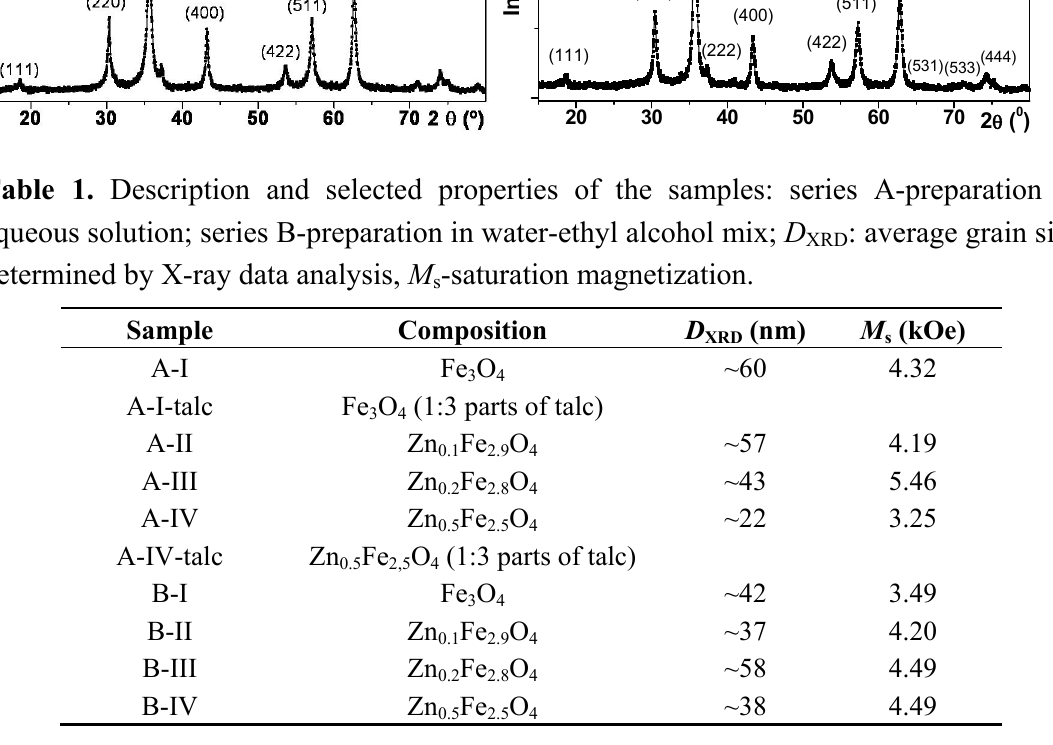
Table 1. Description and selected properties of the samples: series A-preparation in aqueous solution; series B-preparation in water-ethyl alcohol mix; D determined by X-ray data analysis, M